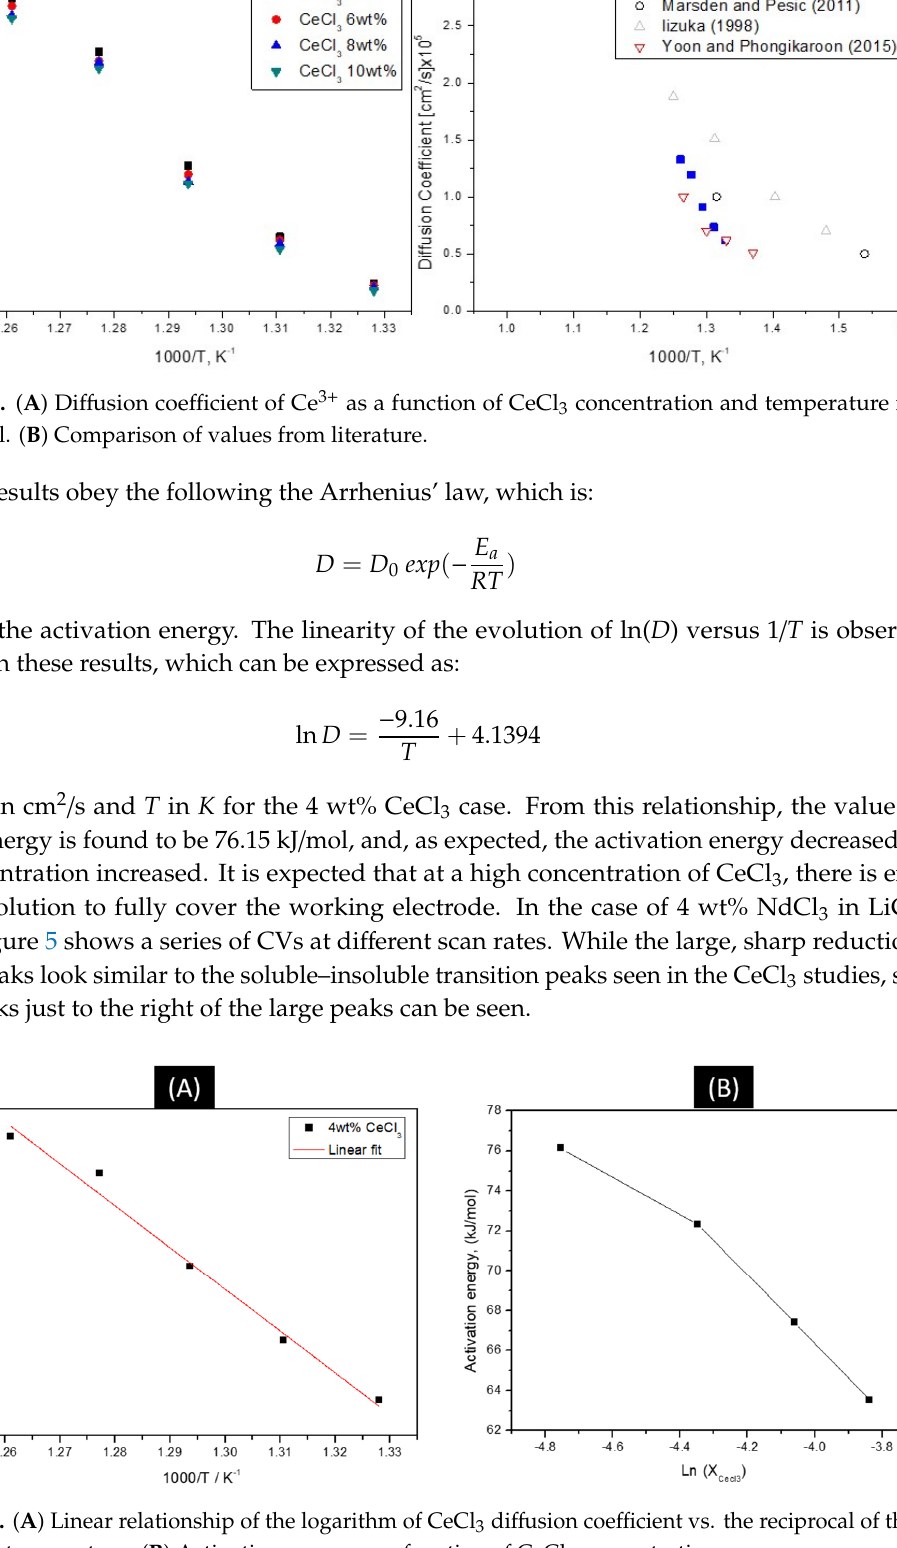
Figure 2. ( A ) Cyclic voltammogram of 4 wt% Ce 3+ /Ce in LiCl-KCl eutectic salt at 773K. ( B ) Dependence of the current versus the square root of the scan rate according to the changing temperature in LiCl- KCl-CeCl 3 (X CeCl3 = 8.626E-03).